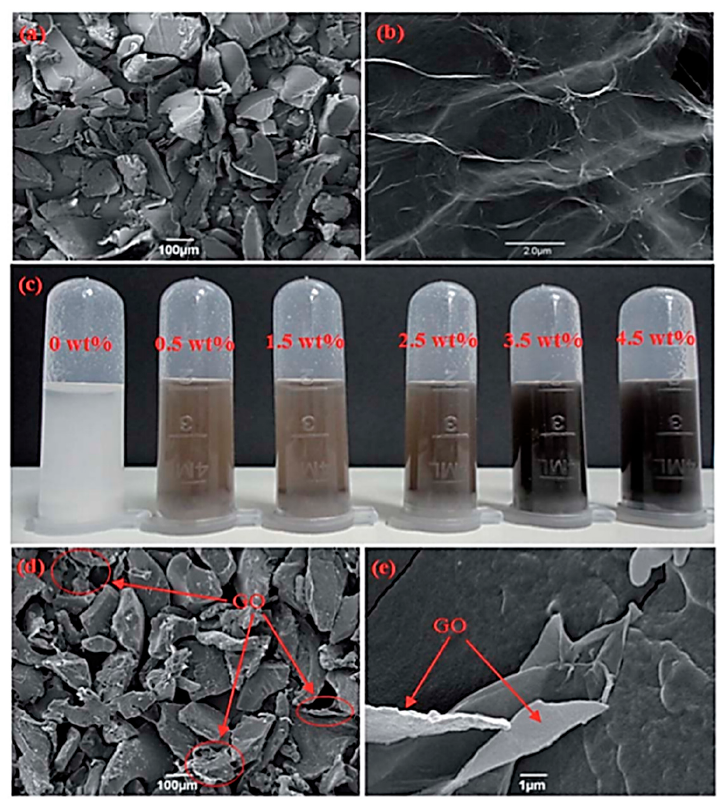
Figure 9. Preparation of poly(vinyl alcohol) (PVA)-GO powder for Selective Laser Sintering (SLS) printing: ( a ) SEM image of initial PVA powder; ( b ) TEM image of initial GO; ( c ) photographs of GO / PVA suspersion in deionized water after ultrasonication; ( d , e ) SEM images of the composite powder after evaporation of water [98].